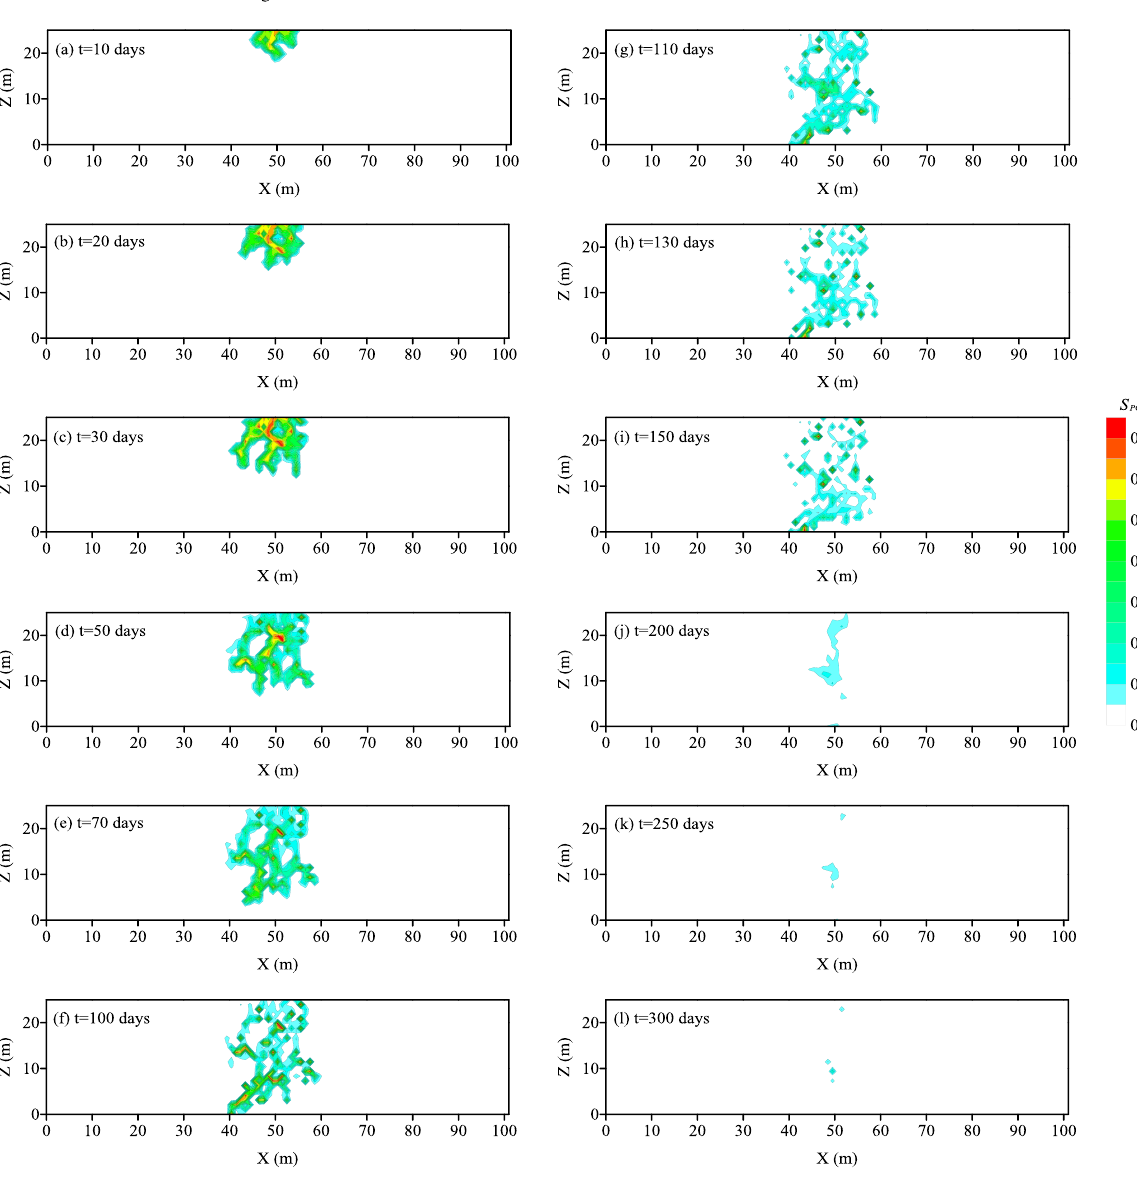
Figure 6. Simulated PCE saturation for individual realization of SPA over the entire migration and remediation periods (0 ∼ 300